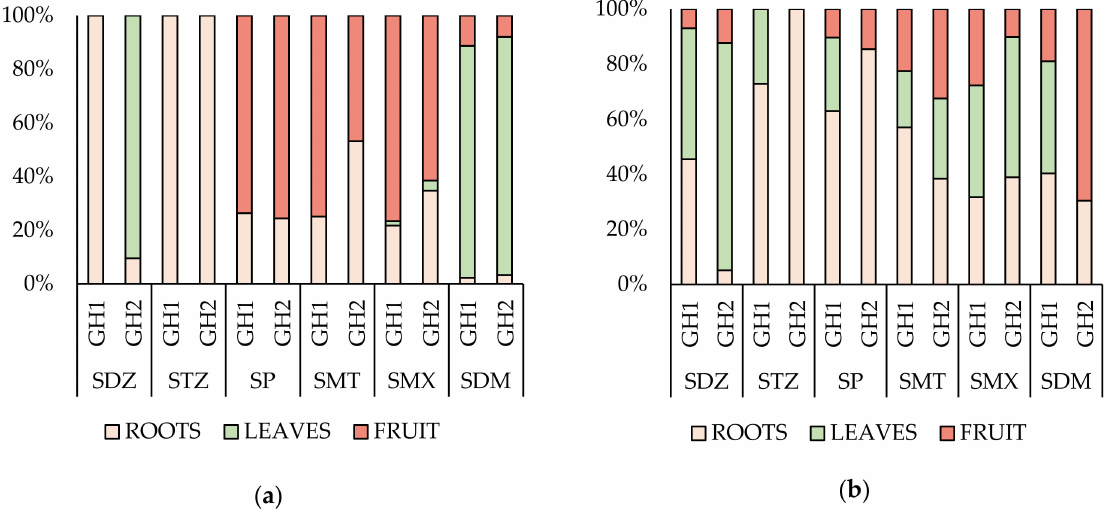
Figure 1. Sulfonamides (sulfadiazine (SDZ), sulfathiazole (STZ), sulfapyridine (SP), sulfamethizole (SMT), sulfamethoxazole (SMX) and sulfadimethoxine (SDM)) distribution in roots, leaves and fruits of the tomato plant during ( a ) 2018 and ( b )